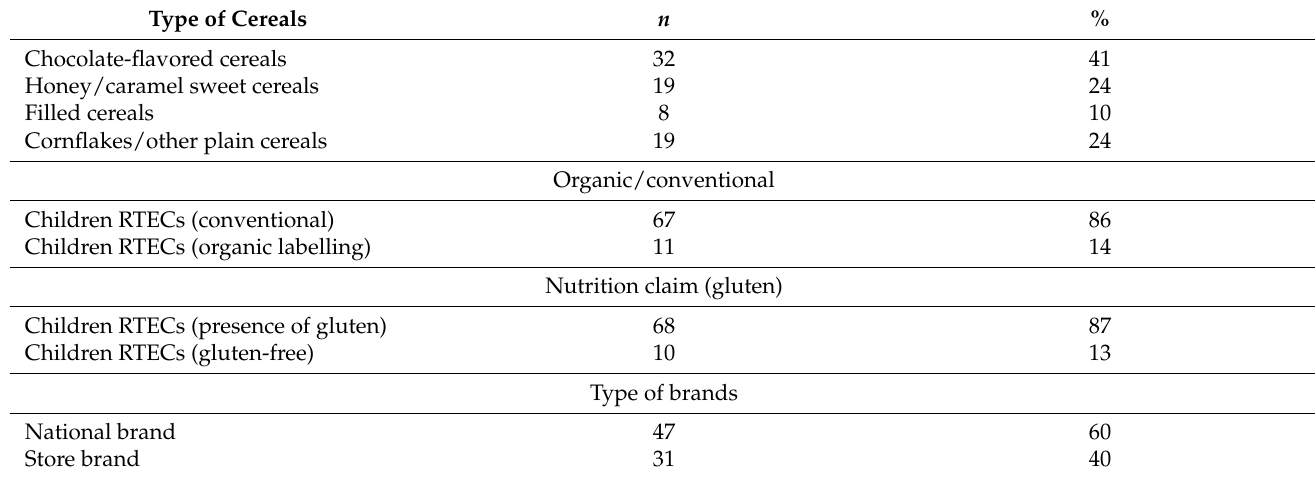
Table 1. RTECs samples distribution per category according to common